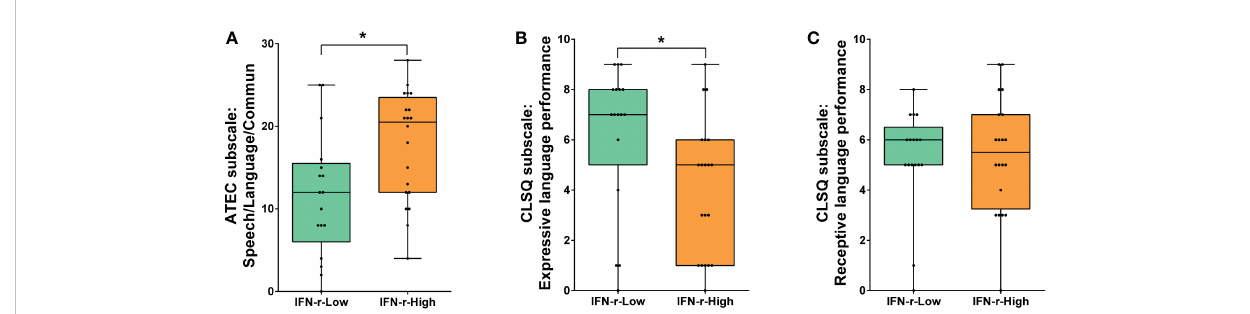
FIGURE 2 Comparison of language function scores between the IFN- g -Low and IFN- g -High groups. (A) Scores of ATEC subscale I: Speech/Language/ Communication; (B) Scores of CLSQ expressive language performance; (C) Scores of CLSQ receptive language performance. The horizontal line and the box indicate the median and the interquartile range (IQR), and the whisker spans the minimum to maximum. * p <0.05.